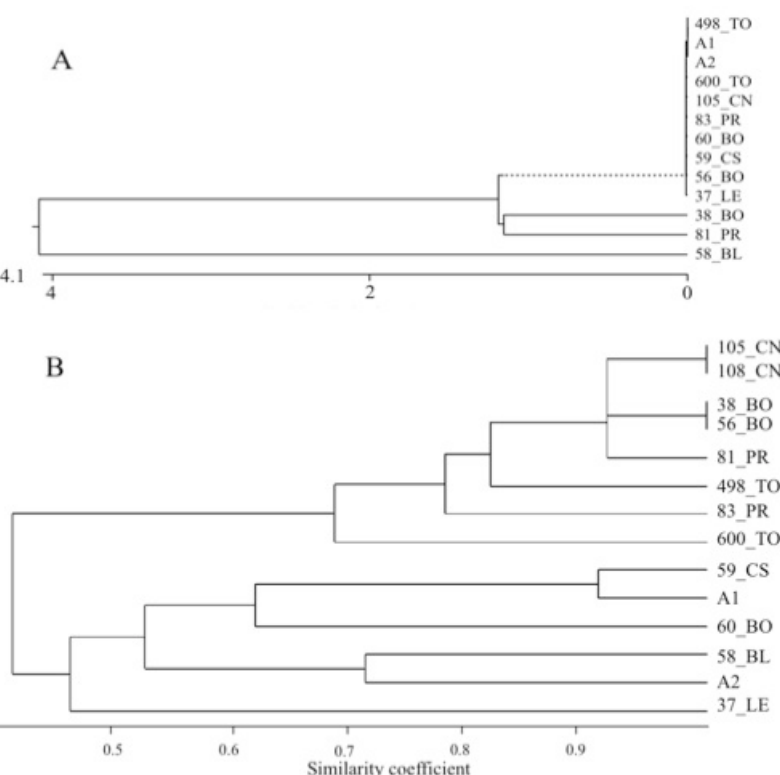
Figure 3. Dendrograms of Phytophthora infestans isolates obtained from A) ITS nucleotide sequences aligned by MegAlign, with bootstrap test results on each node, and B) SSR matrix analysis by unweighted pair-group method with average link - age (UPGMA) using Dice’s